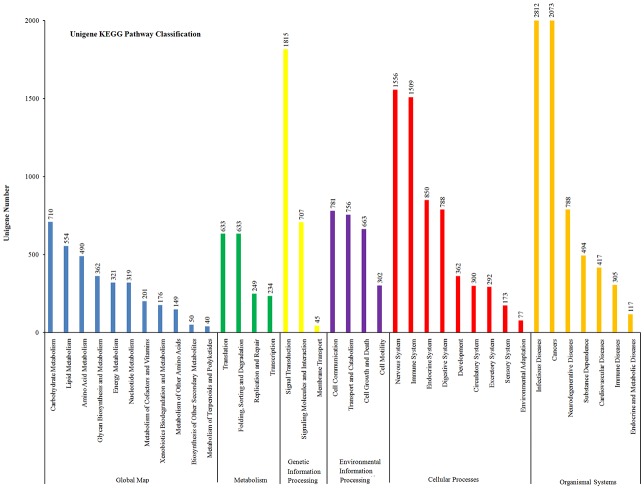
Classification of unigenes on the basis of KEGG categorization.